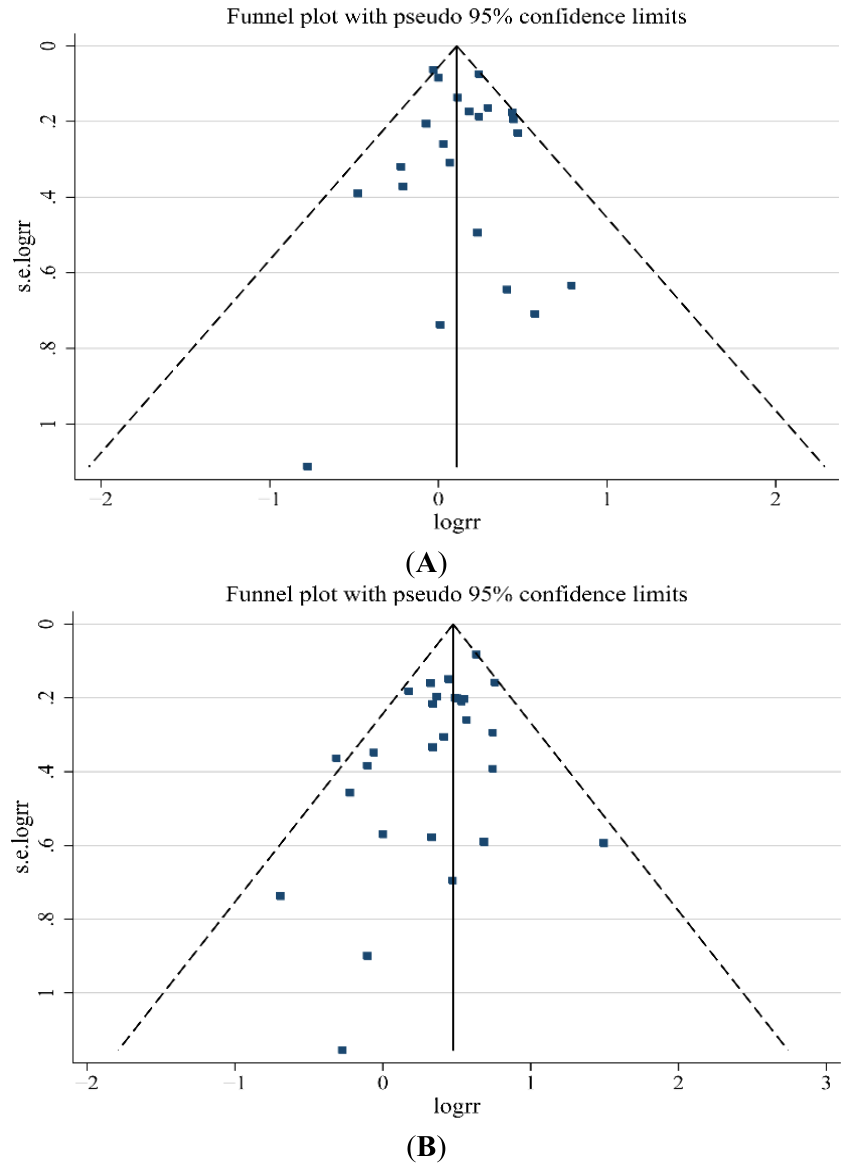
Figure 3. ( A ) Funnel plot of studies evaluating the association between overweight and gallbladder cancer risk ( p = 0.483); ( B ) Funnel plot of studies evaluating the association between obesity and gallbladder cancer risk ( p = 0.019).